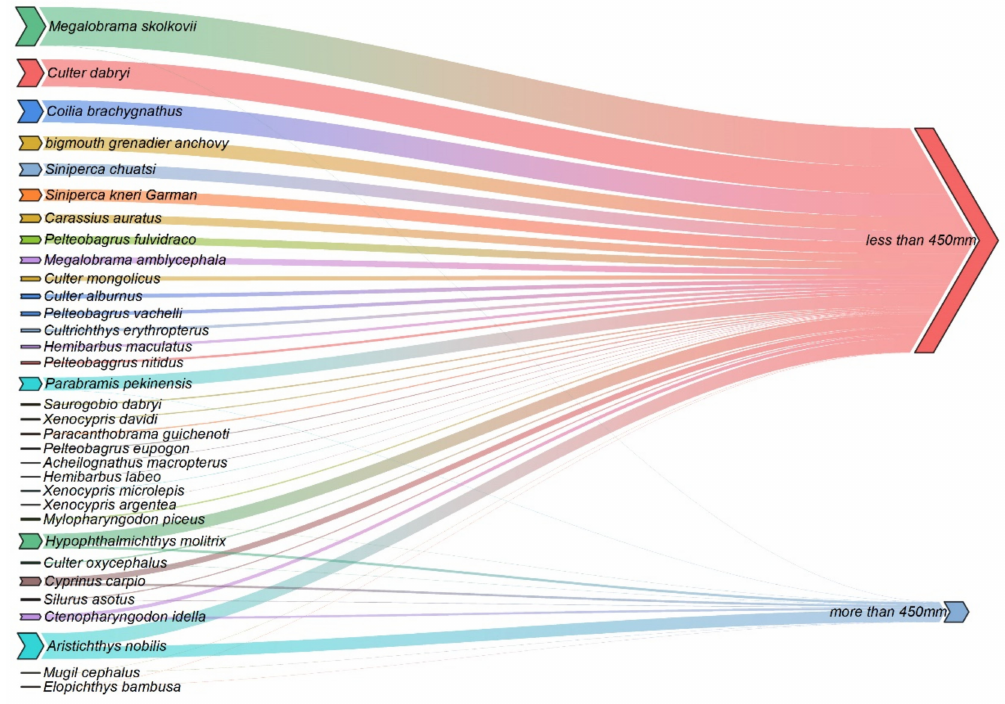
Figure 6. Composition of catches with a body length less than and more than 450 mm.